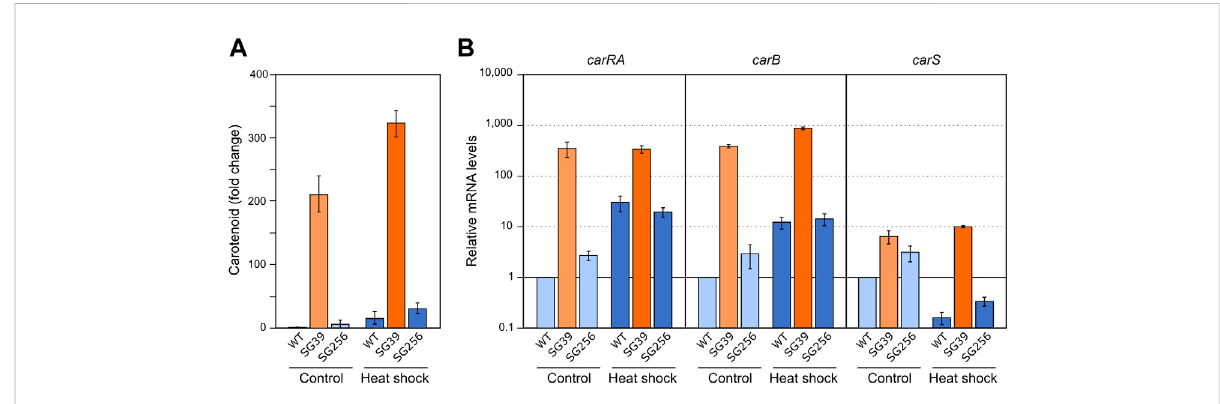
FIGURE 4 Effect of heat shock on carotenoid production and expression of car genes. (A) Relative carotenoid production in the wild type (WT), carS mutant(SG39),andthecomplementedmutant(SG256)measured1dayafter1 hourofheatshock. (B) Expressionof carRA,carB and carS genesafter 1-hheatshock. Thethreestrainsweregrown inDGmediumfor 3daysat30 ° Cindarknessandincubatedfor 1 hour at42 ° C.RNAwasextracted from samplestakenaftertheheatshockandcarotenoidsfromsamplesincubated24 hat30 °